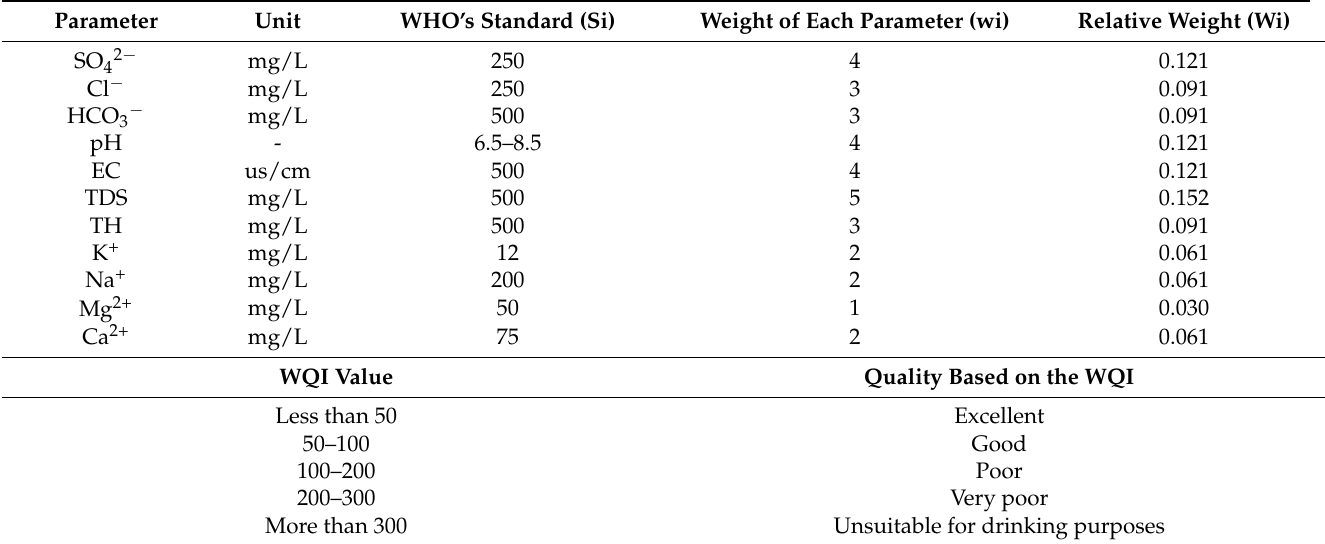
Table 1. Weight and relative weight of each parameter used to calculate the WQI and water quality classification ranges and types of water based on Water Quality Index (WQI)